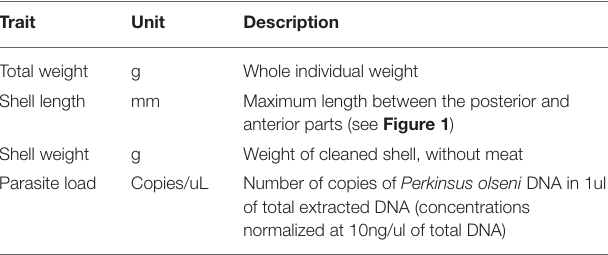
TABLE 1 | Description of the traits recorded for each individual clam during the large-scale phenotyping and DNA sampling. Trait